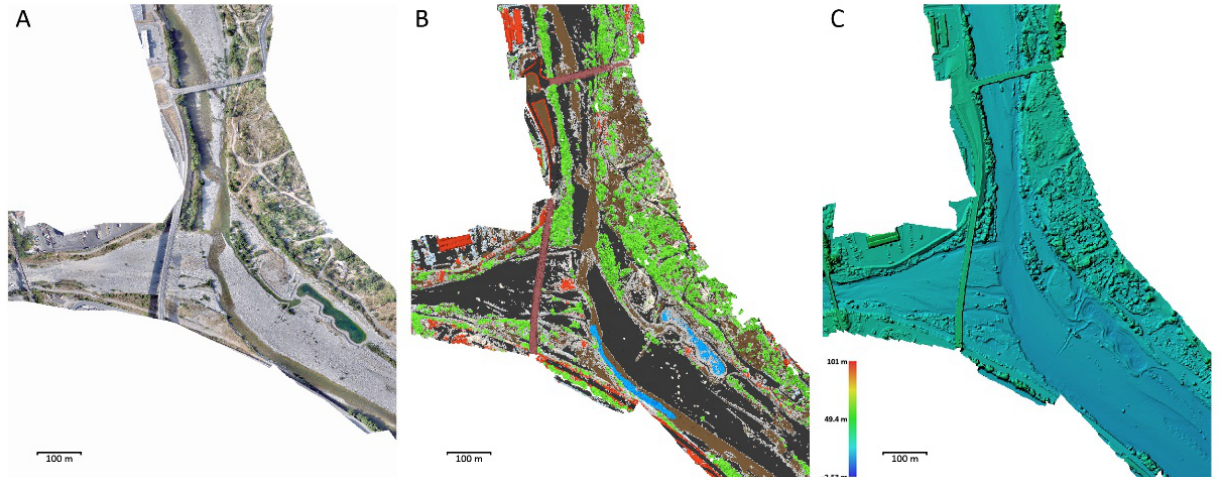
Figure 4. Products obtained by the 2017 survey. ( A ) Orthophoto; ( B ) classified dense cloud. In green, light blue, black, brown, and red are colored vegetation, deep water, riverbed, streets, and buildings, respectively. ( C ) Digital surface model (DSM).